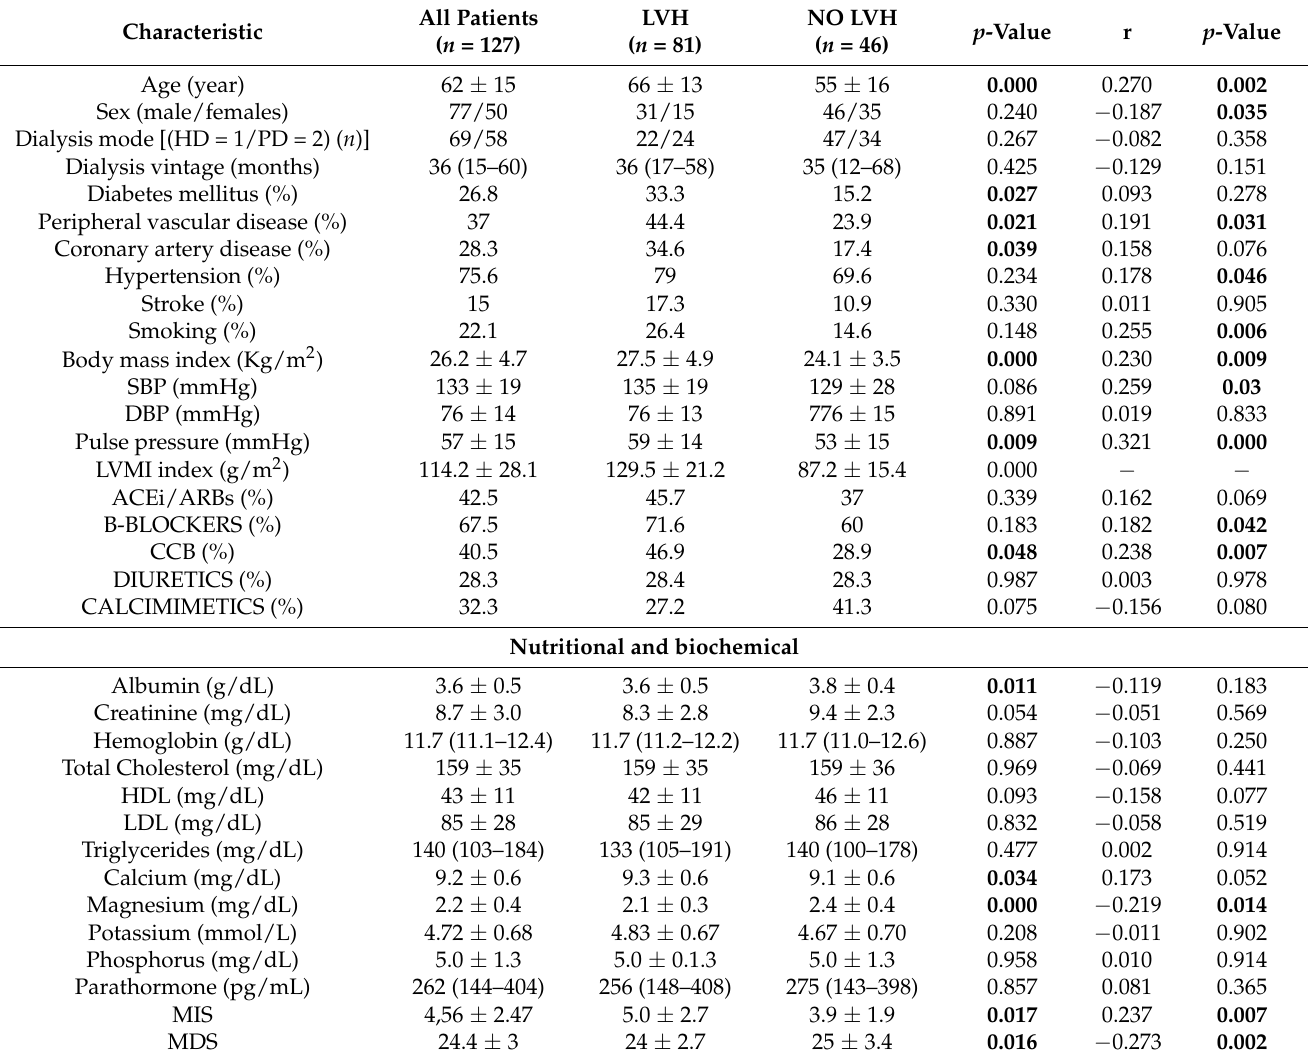
Table 2. Clinical and epidemiological characteristics of the study population by left ventricular hypertrophy